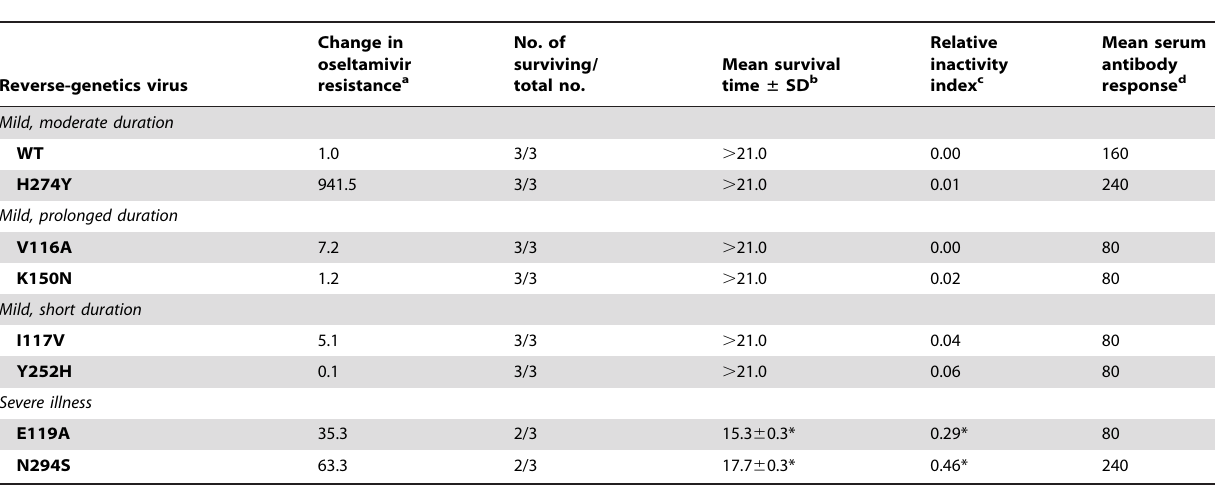
Table 3. Pathogenicity of the Recombinant H5N1 Influenza Viruses in Ferrets.